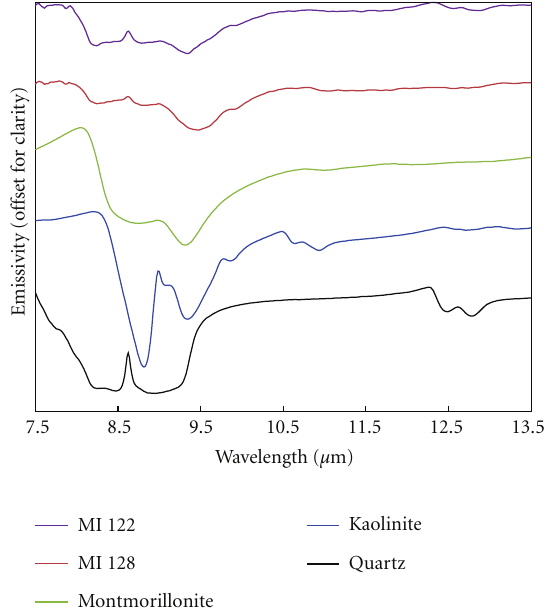
Figure 3: Example MicroFTIR emissivity spectra of Tick Hill soil samples and ASL [26] highlighting the presence of mixtures of clay and quartz minerals within the